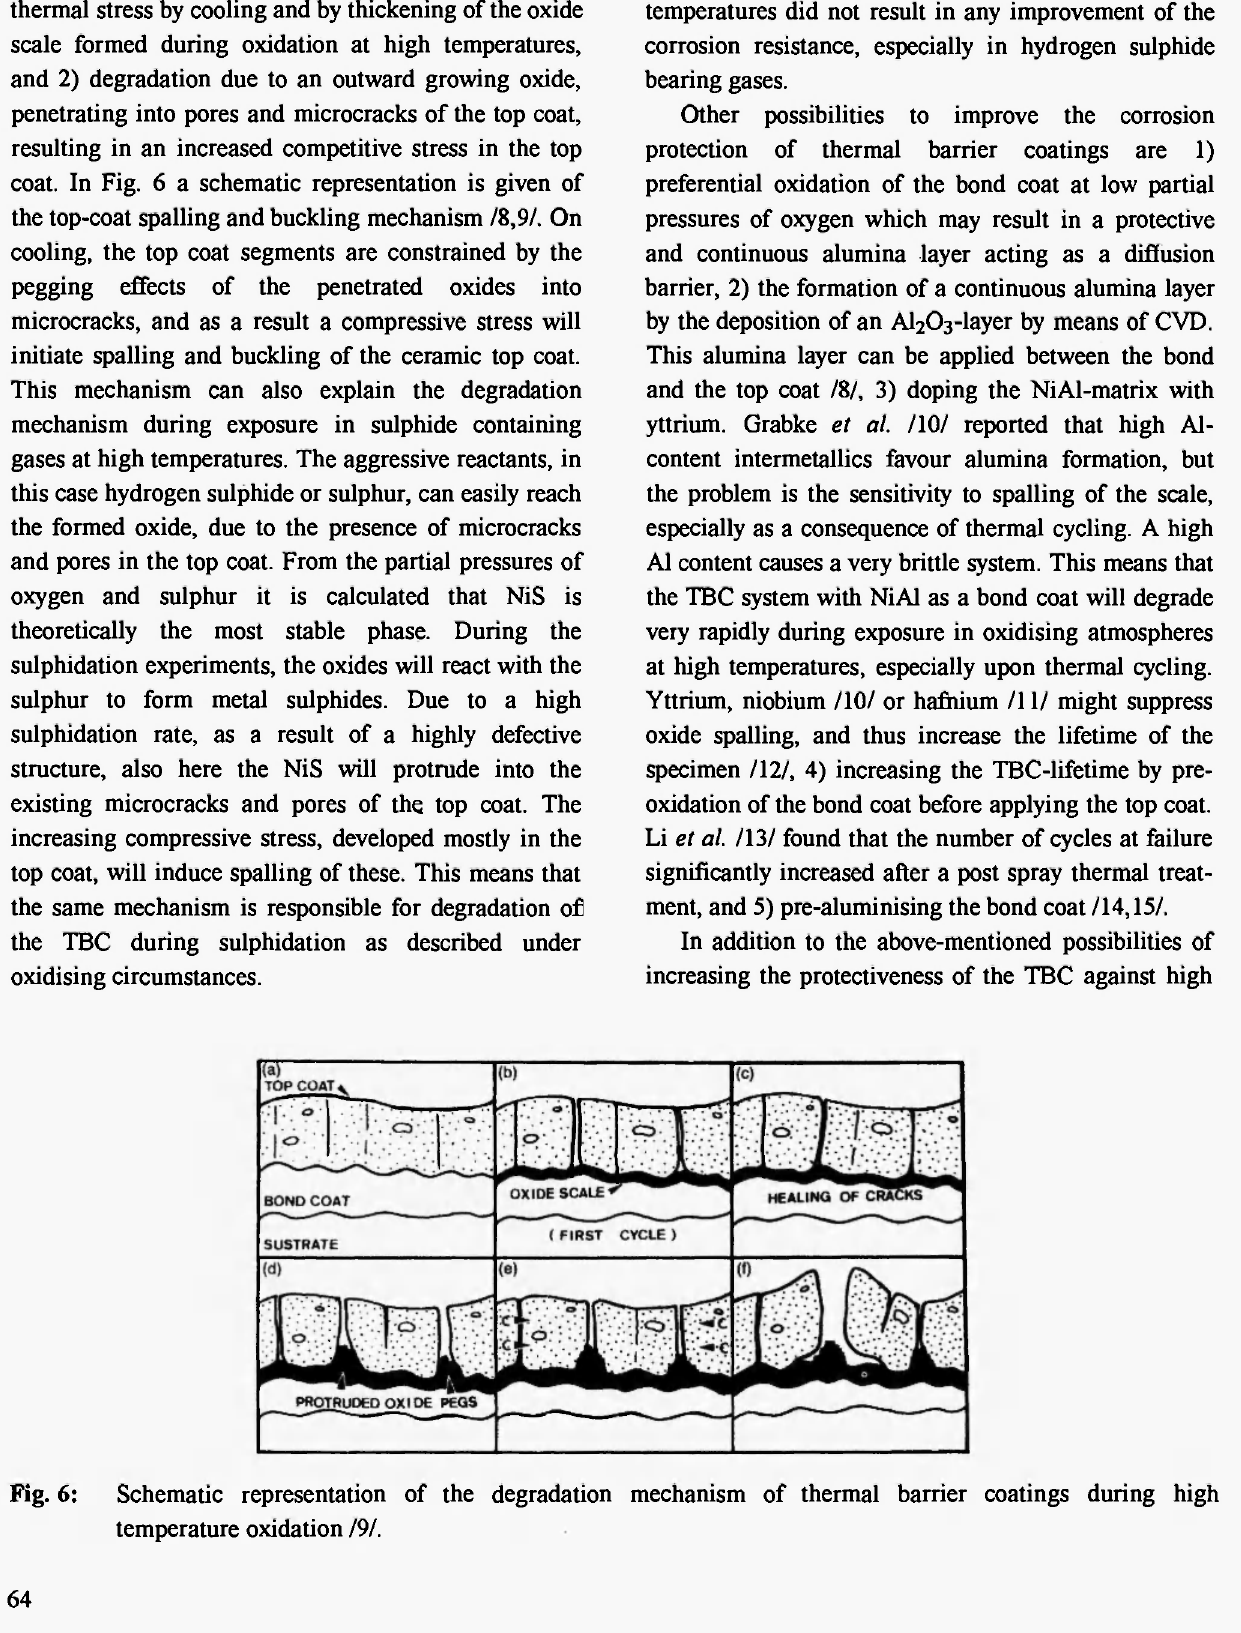
Schematic representation of the degradation mechanism of thermal barrier coatings during high temperature oxidation